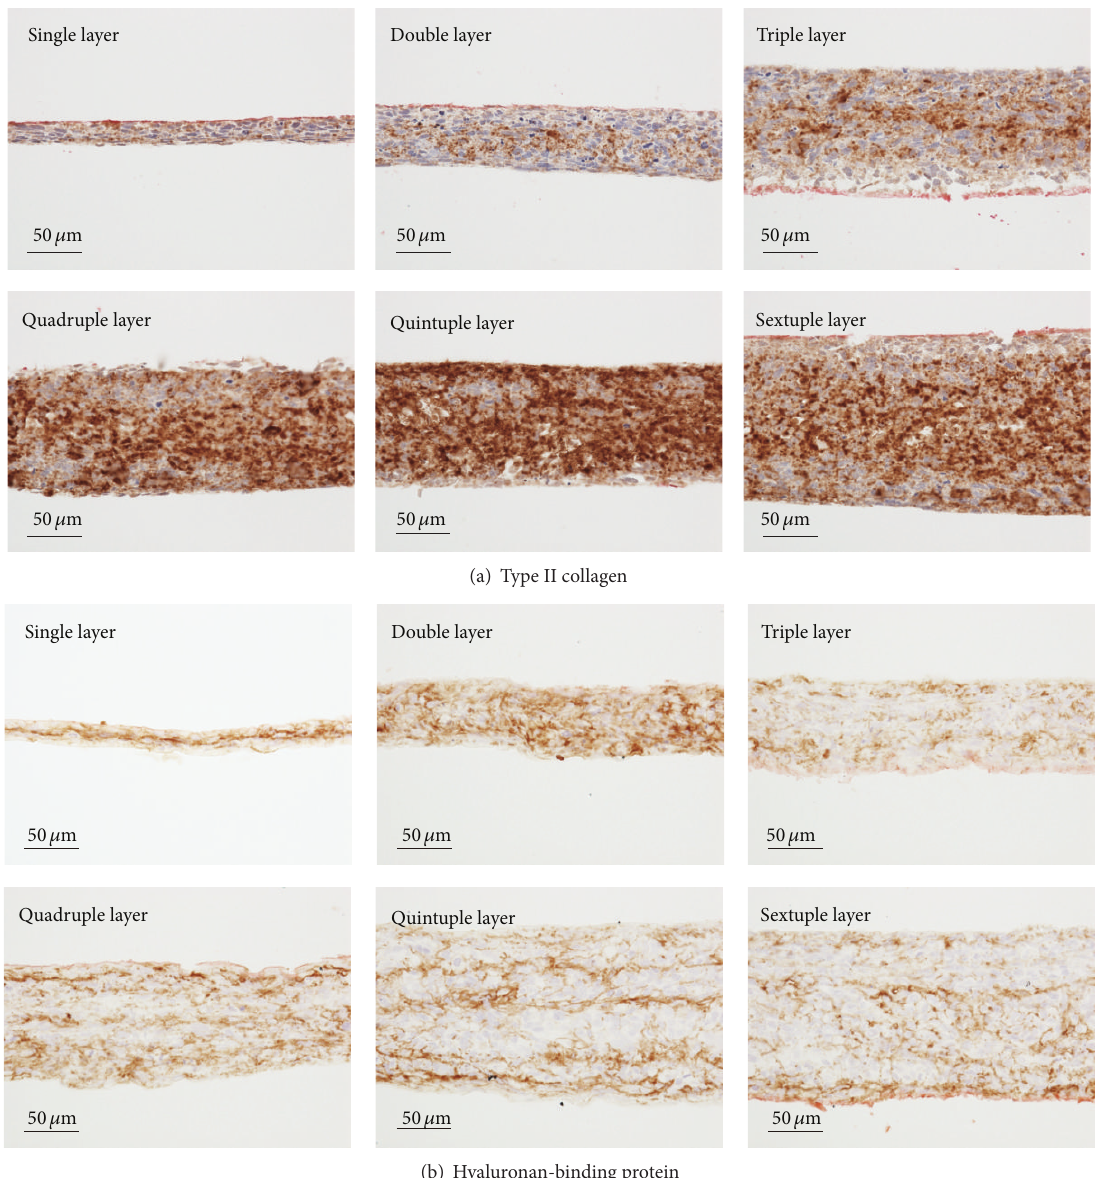
Figure 3: Detection of chondrospecific markers in layered cell sheet constructs at 24 h after layering by immunohistochemistry. Cells in single- and multilayered cell sheet constructs expressed type II collagen (a) and hyaluronan-binding protein